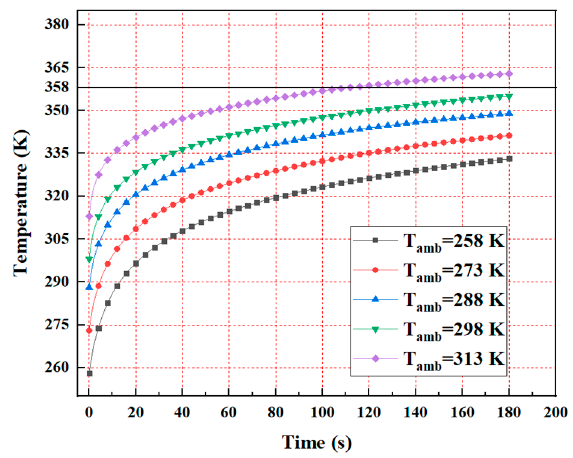
Figure 11. Evolution of the hydrogen temperature rise at di ff erent ambient temperatures.